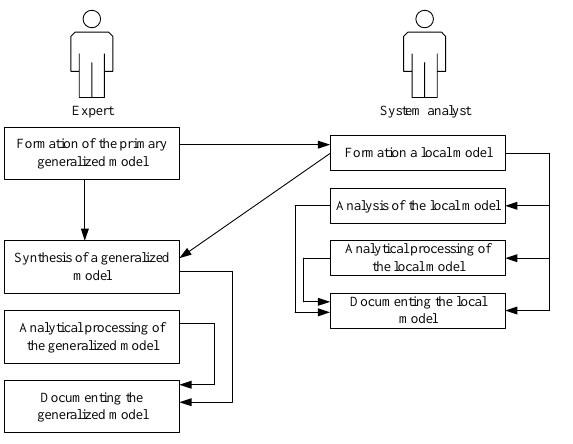
Fig 3. Information flows between classes of integrated environment modules